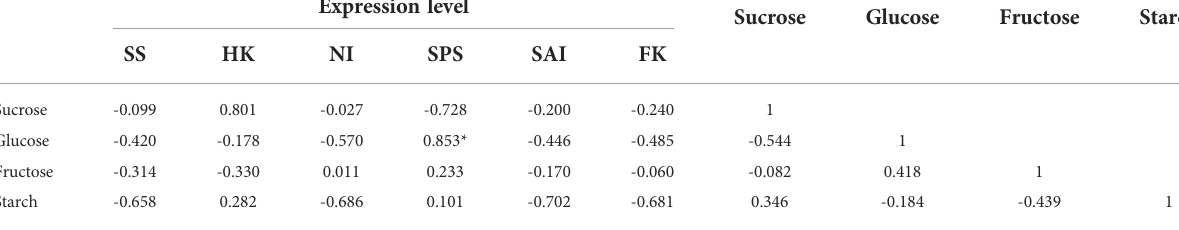
TABLE 1 Correlation coef fi cient between expression of related key genes with sugar and starch content in ‘ Yilv ’